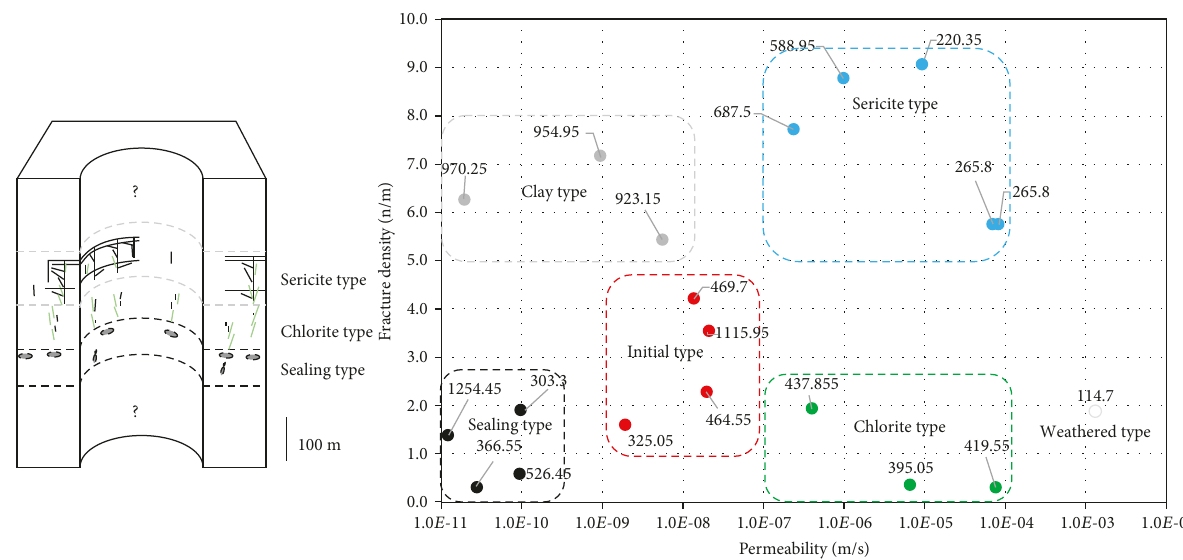
Figure 10: Relationship between the hydraulic conductivity and fracture density of the MIZ-1 borehole. The extents of four types of hydrothermal fl uid fracture and a clay type are each surrounded by dotted and coloured boxes. Small numbers show the centre depth of each hydraulic test section. A schematic distribution of three representative types (sealing type, chlorite type, and sericite type) are shown on the right side. A weathered type was recognized as an outlier; this fracture probably experienced stress relief beneath the